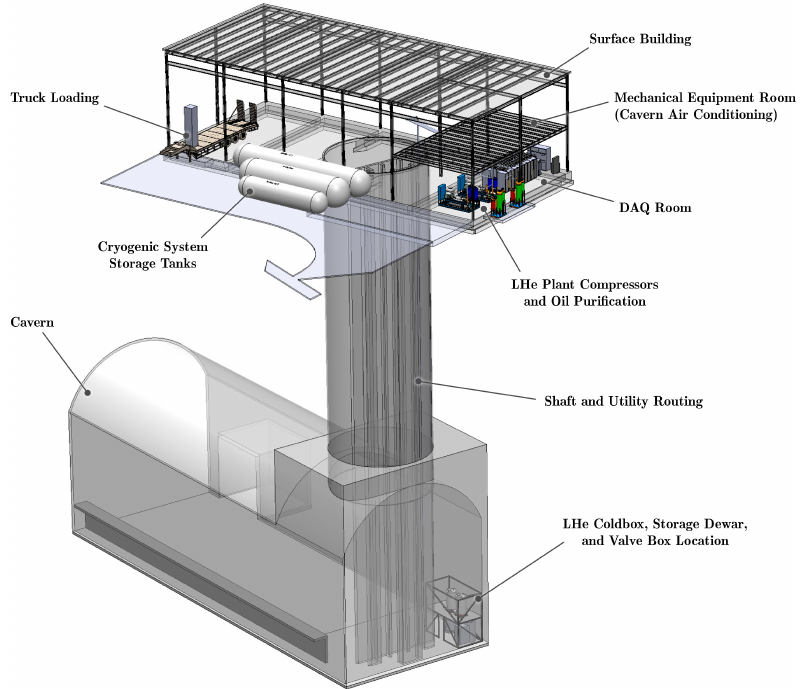
Figure 180. The surface building houses important support equipment for detector as well as building operation. In addition, the building provides rigging and staging capabilities to lower equipment into the underground